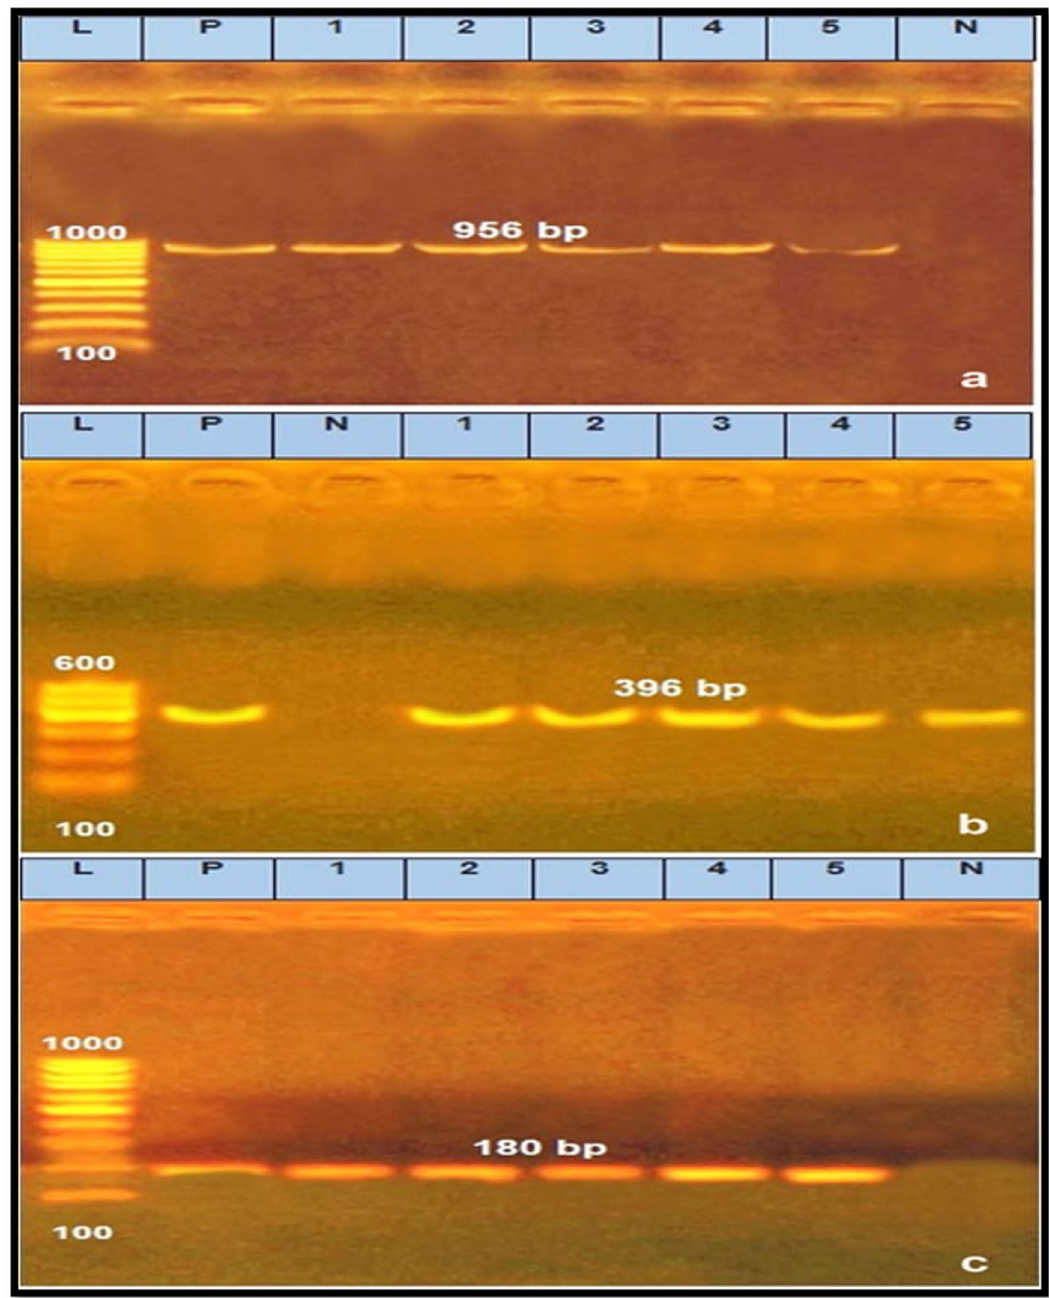
Figure 1. Agarose gel electrophoresis for PCR products of P. aeruginosa species identification using 16S rDNA gene ( a ), amplified 356 bp and the virulence genes ( b , c ), amplified 396 and 180 bp for toxA and fliC genes, respectively. Lane (L): 100 bp Ladder ‘’Marker’’, Lane): 1–5), the examined samples, Lane Pos: Positive control, Lane Neg: Negative